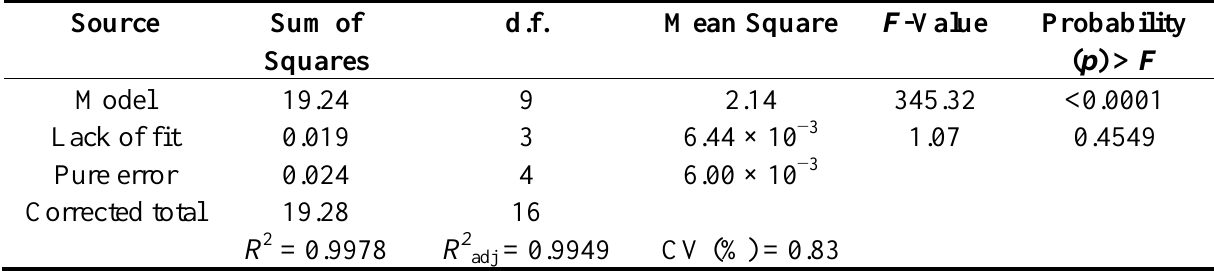
Table 2. Analysis of variance (ANOVA) for the fitted quadratic polynomial model for optimization of WPS yield.